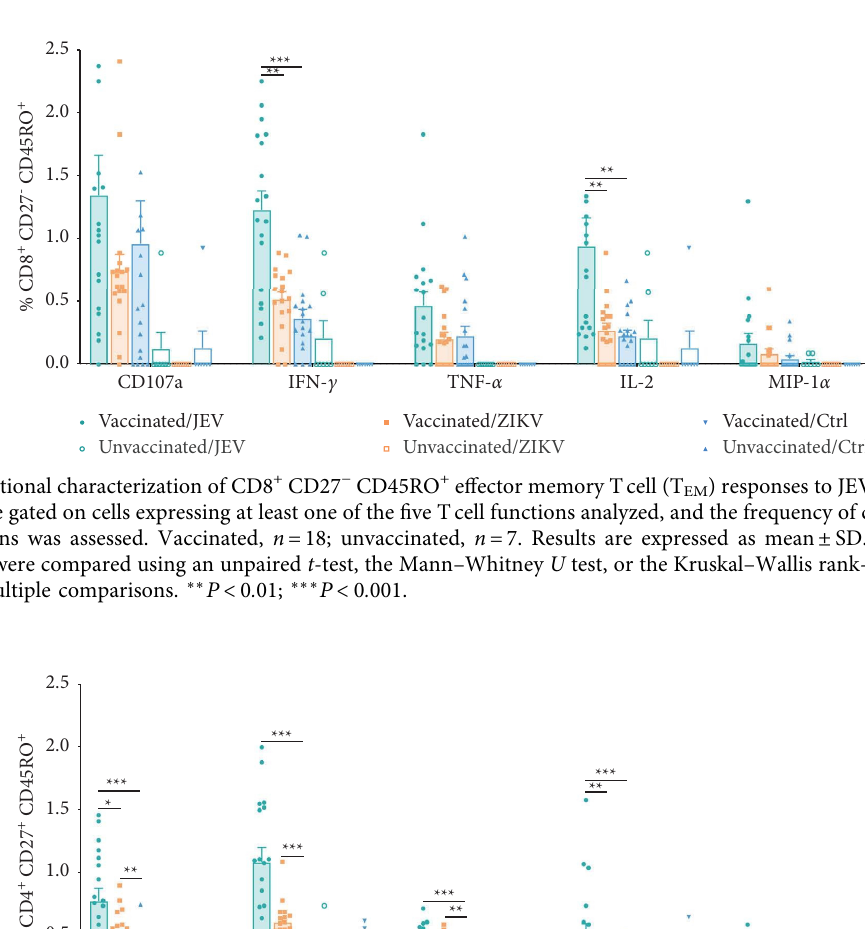
+ T CM ) responses to JEV or ZIKV. CD4 CM